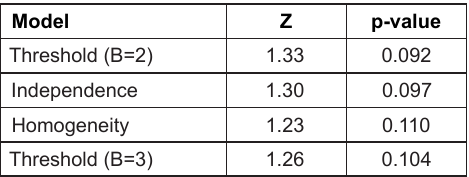
Table 41. Tests for randomness of collared caribou for the Tuktoyaktuk Peninsula herd 2009 data set.